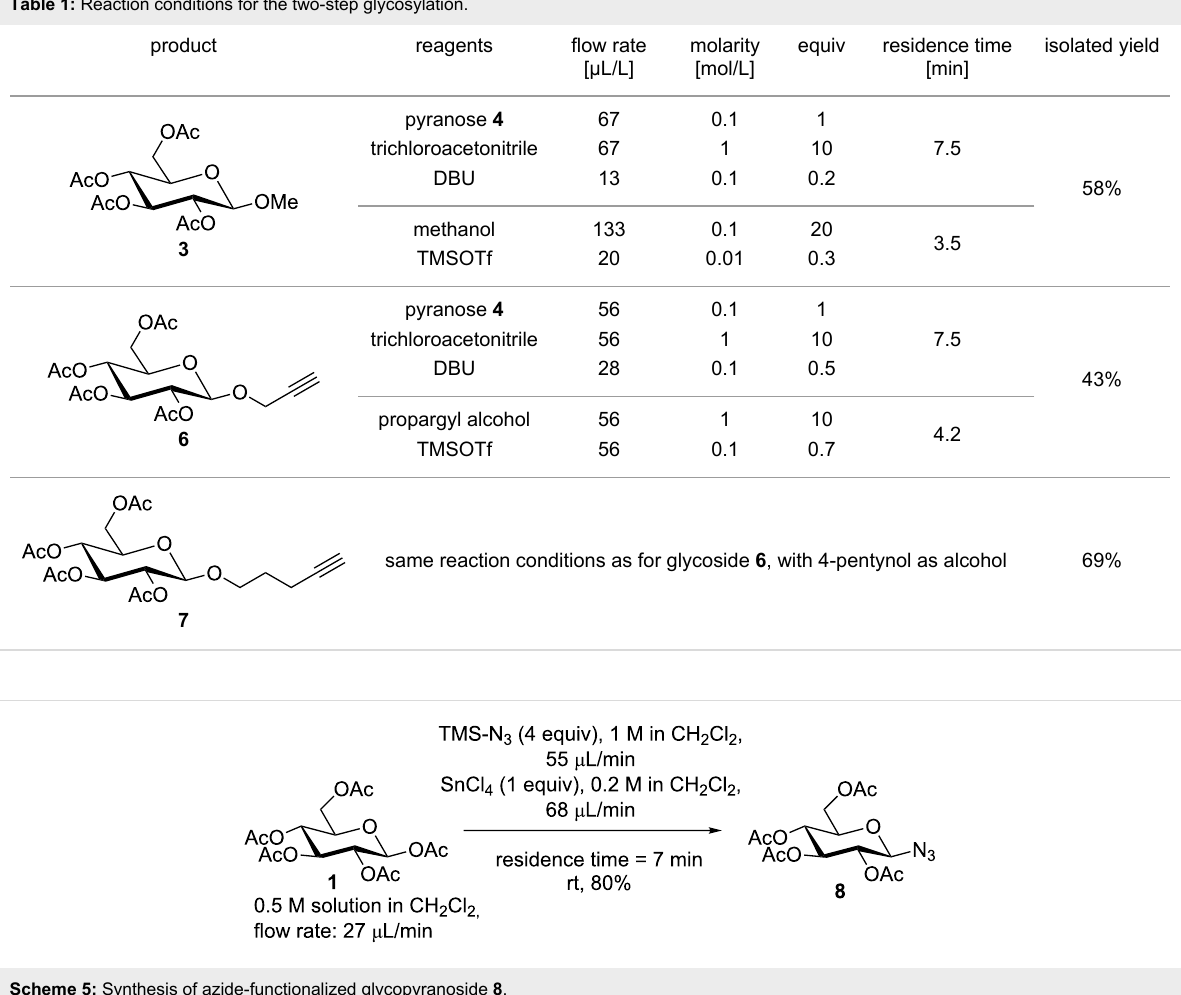
Table 1: Reaction conditions for the two-step glycosylation.